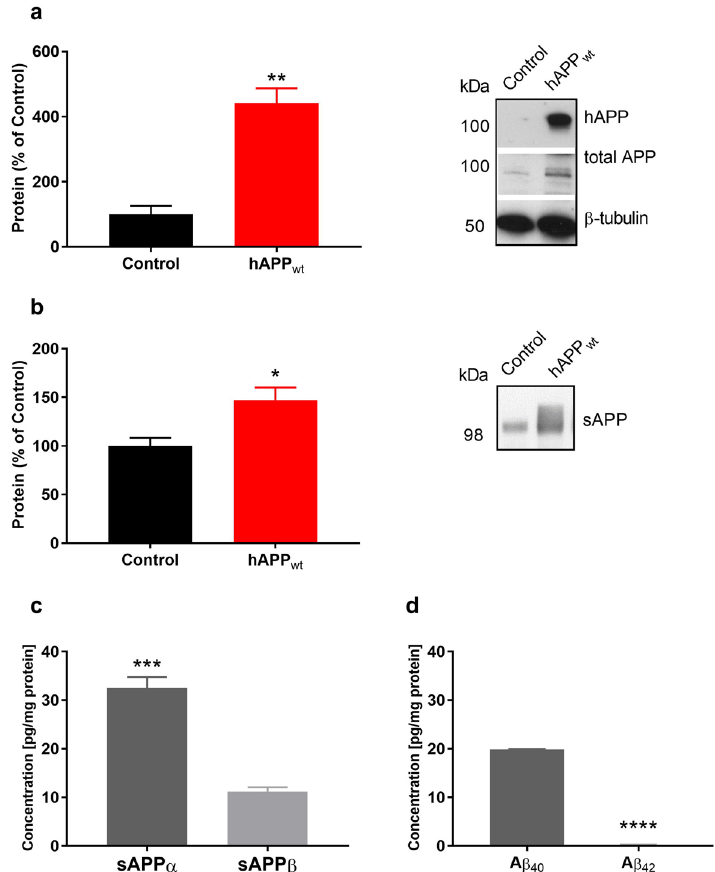
Figure 1. Characterization of APP metabolism in 6 month old male hAPP wt mice and control littermates. ( a ) Quantification of total (mouse and human) APP (left panel) and representative western blots of human APP (hAPP) and total APP in hippocampal tissue lysates of 6 month old hAPP wt (n = 4) and control (n = 4) animals (protein amount was normalized to β-tubulin and expressed as percentage). ( b ) Quantification and representative western blot of soluble mouse and human APP measured in medium collected from organotypic brain slice cultures of 6 months old hAPP wt (n = 3) and control (n = 3) animals (protein amount was normalized to controls and expressed as percentage). ( c ) Quantitative determination of soluble human APP (sAPPα/sAPPβ) and ( d ) human amyloid peptides (Aβ 40 /Aβ 42 ) in hippocampal tissue lysates of 6 month old male hAPP wt (n = 4 for sAPPα/sAPPβ; n = 3 for Aβ 40 /Aβ 42 ). No human sAPPα/sAPPβ or human Aβ 40 /Aβ 42 was detected in control samples (ECLIA measurements were normalized to the protein content of each sample; Values are means ±